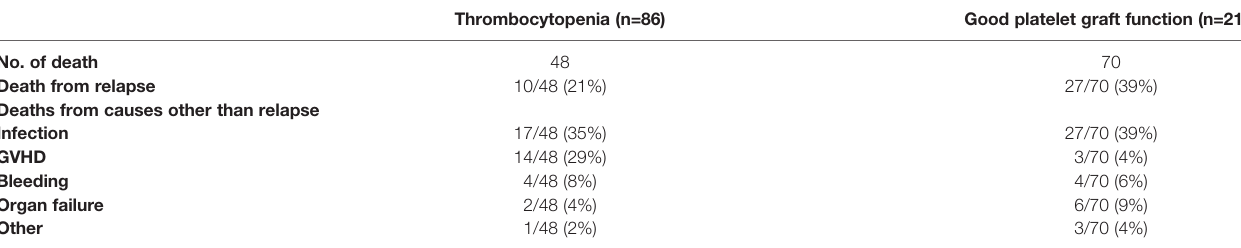
TABLE 4 | Causes of death in MDS patients after